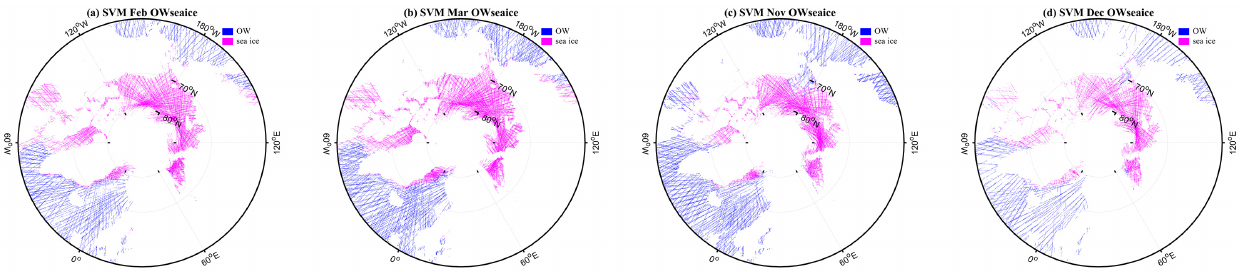
Remote Sens. 2021 , 13 , x FOR PEER REVIEW 23 of 28 Figure A8. SVM for OW-sea ice classification using the data in April as the training set. The data in ( a ) February, ( b ) March, ( c ) November, and ( d ) December are used as the test set in turn.